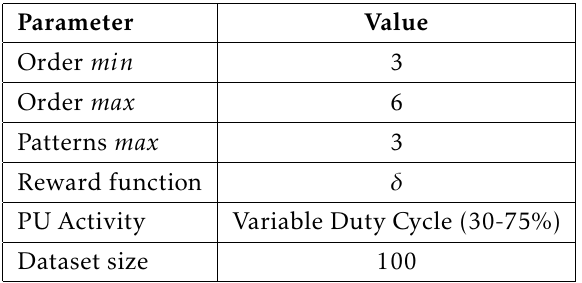
Table 1. Hypernetwork parameter settings